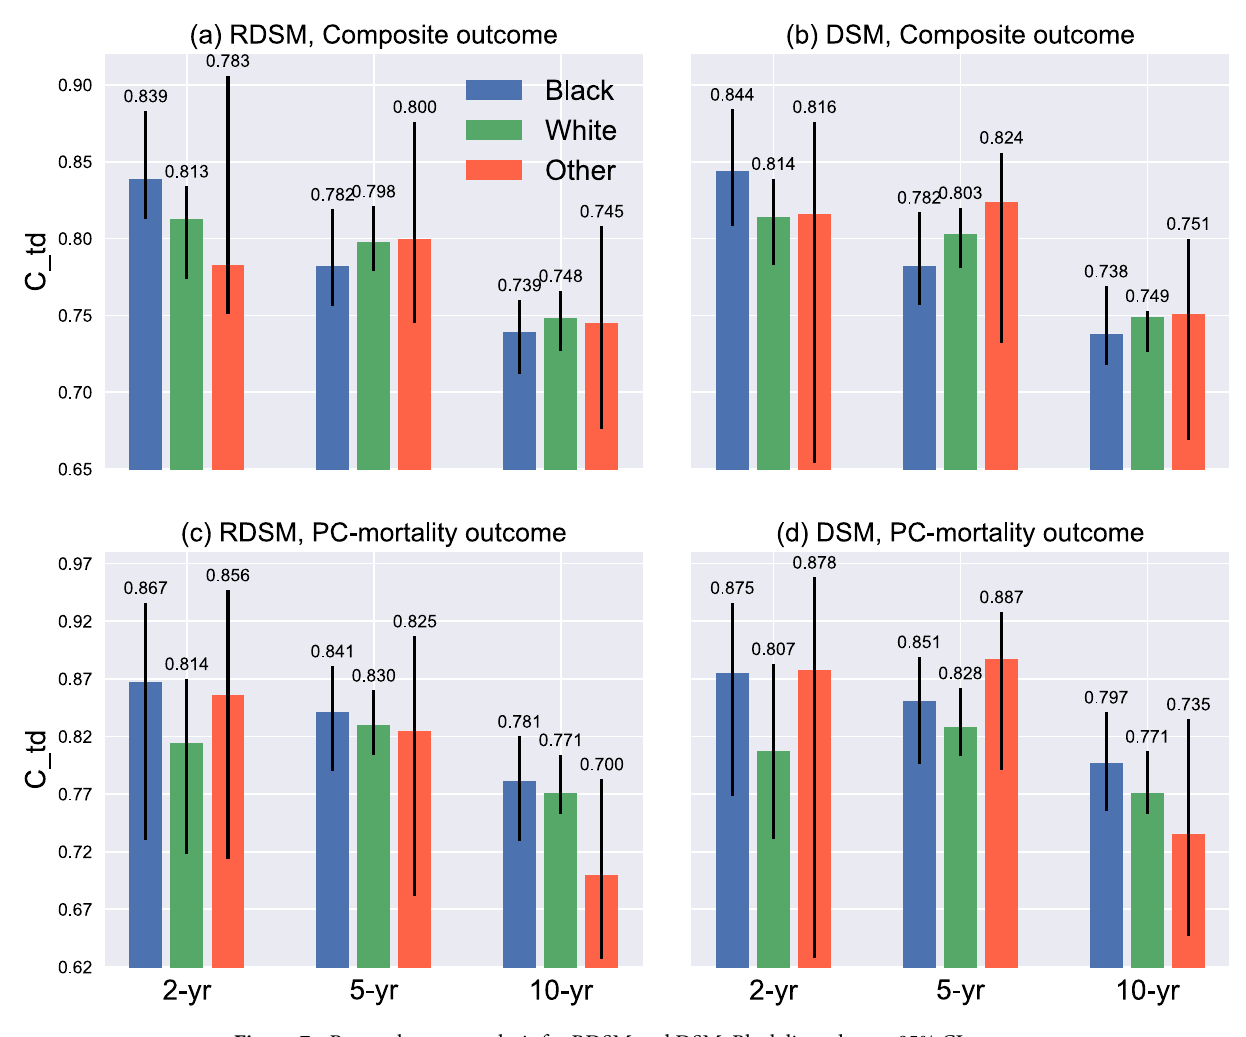
Figure 7. Race subgroup analysis for RDSM and DSM. Black lines denote 95% CI.